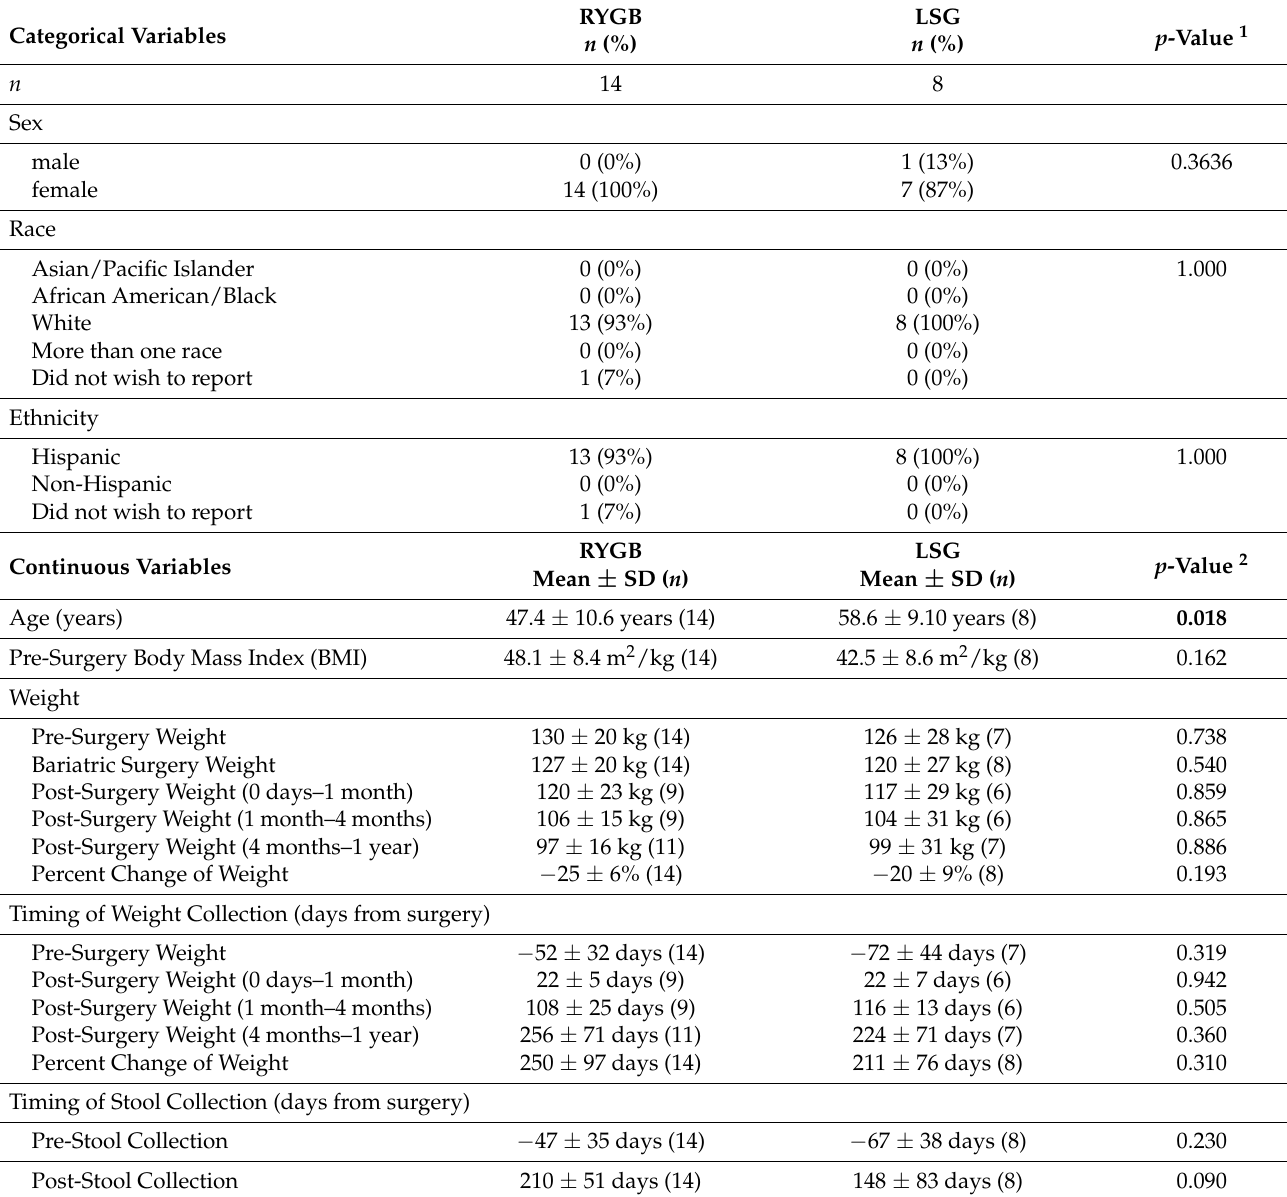
Table 1. Characteristics of study participants, stratified by surgery type. Significance denoted with unadjusted p -value < 0.05